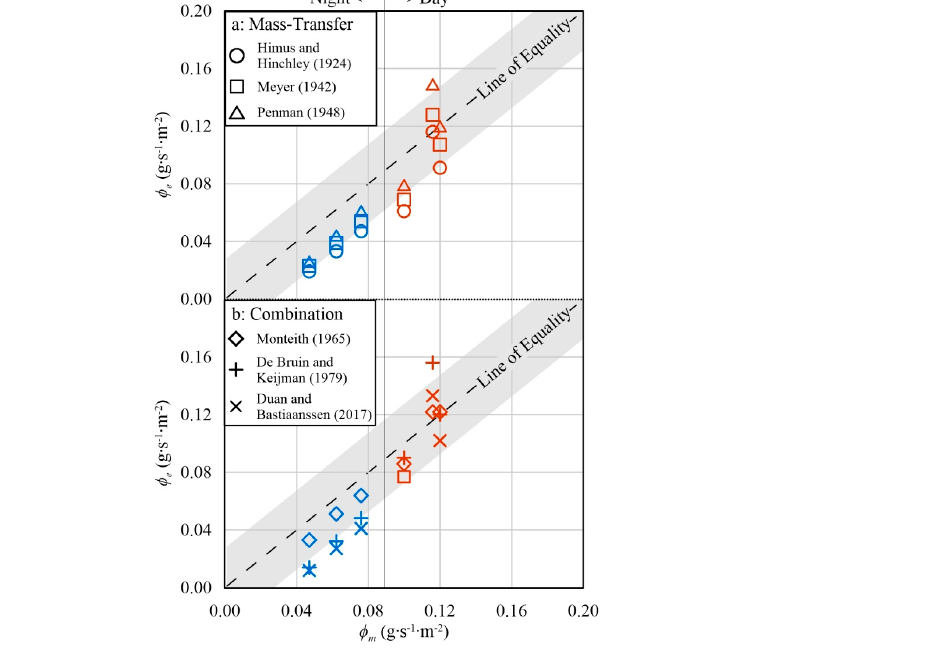
Figure 7. Comparison of estimated vapour flux ( φ e ) and measured vapour flux ( φ m ) based on: ( a ) mass-transfer equations and ( b ) combination